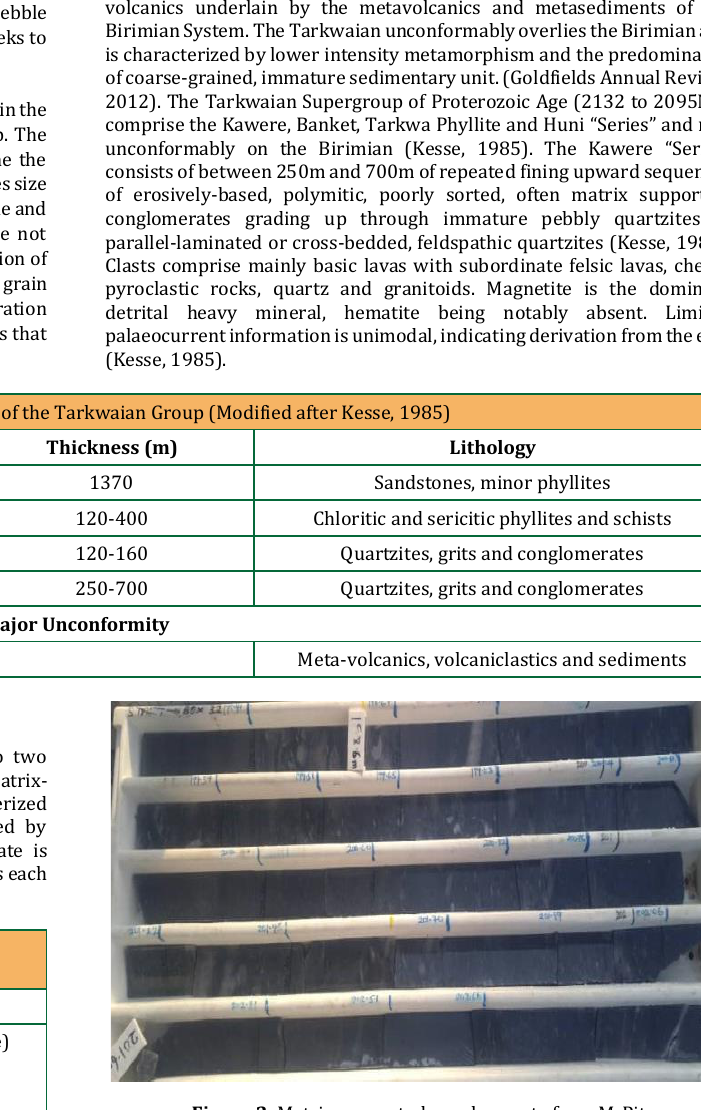
Figure 2: Matrix supported conglomerate from